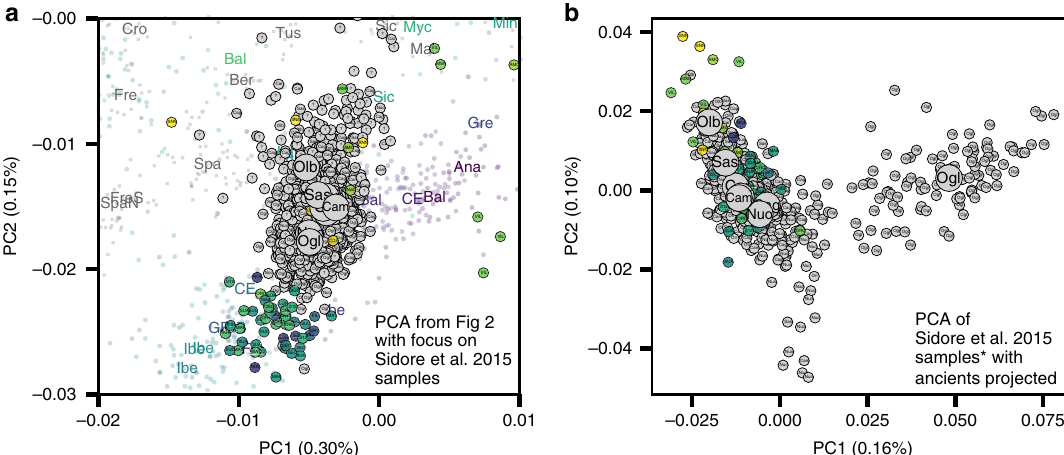
Fig. 5 Present-day genetic structure in Sardinia reanalyzed with aDNA. a Scatter plot of the fi rst two principal components from Fig. 2a with a zoom-in on present-day Sardinia diversity in our sample 33 . Median PC values for each Sardinian region are depicted as large circles. b PCA results based on present- day Sardinian individuals, subsampling Cagliari and Ogliastra to 100 individuals to avoid effects of unbalanced sampling. In both panels, each individual is labeled with an abbreviation that denotes the source location if at least three grandparents were born in the same geographical location ( “ small ” three- letter abbreviations) or if grand-parental ancestry is missing with question mark. We also projected each ancient Sardinian individual on to the top two PCs (points color-coded by age, see Fig. 1 for the color